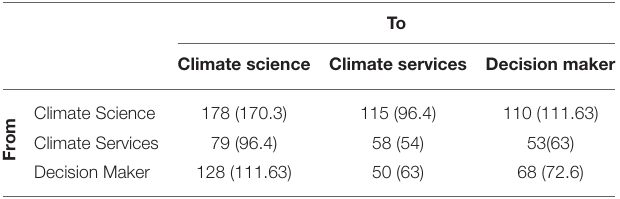
TABLE 3 | Block model permutation test.